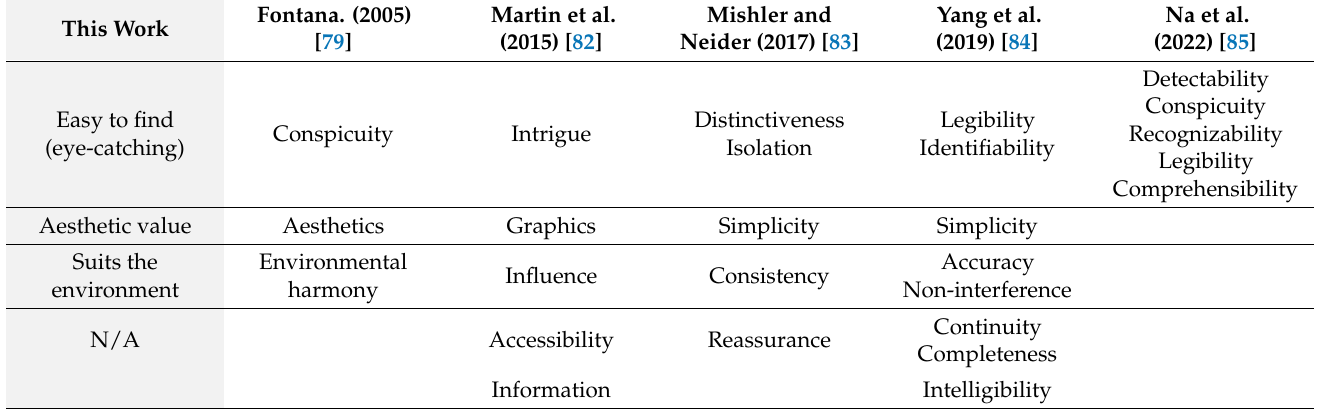
Table 2. Questionnaires referenced for assessing the quality of sign designs.